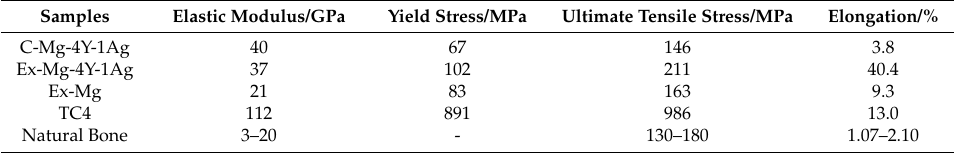
Table 1. Mechanical properties of different metal samples.